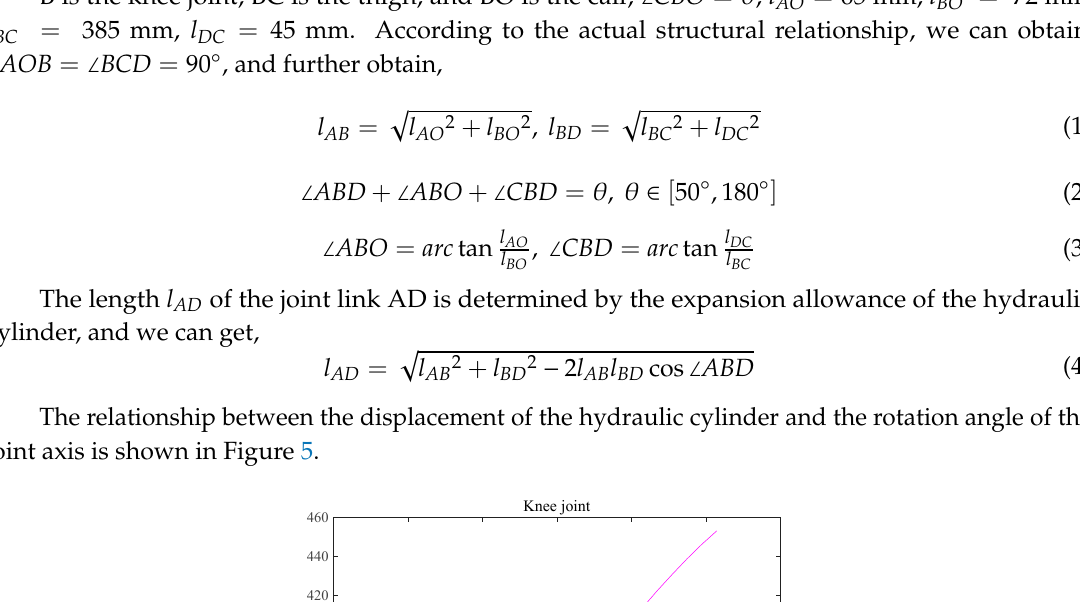
Figure 5. Relationship curve between cylinder displacement and joint angle.